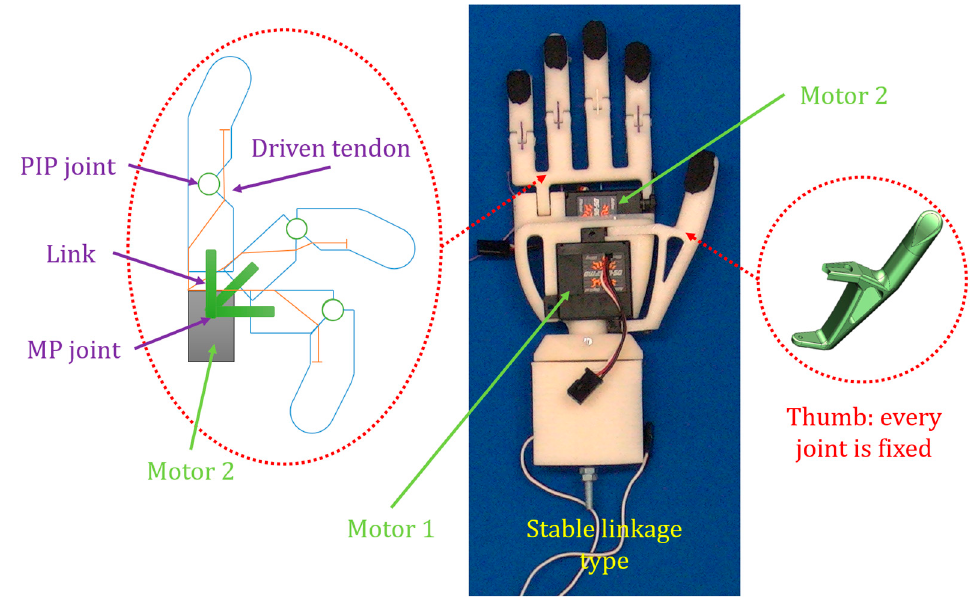
Figure 19. Stable linkage type: the assembled hand, part of the thumb, and tendon-driven mechanism of the four fingers. Table 4. Achievable motion types (joint fixed type).